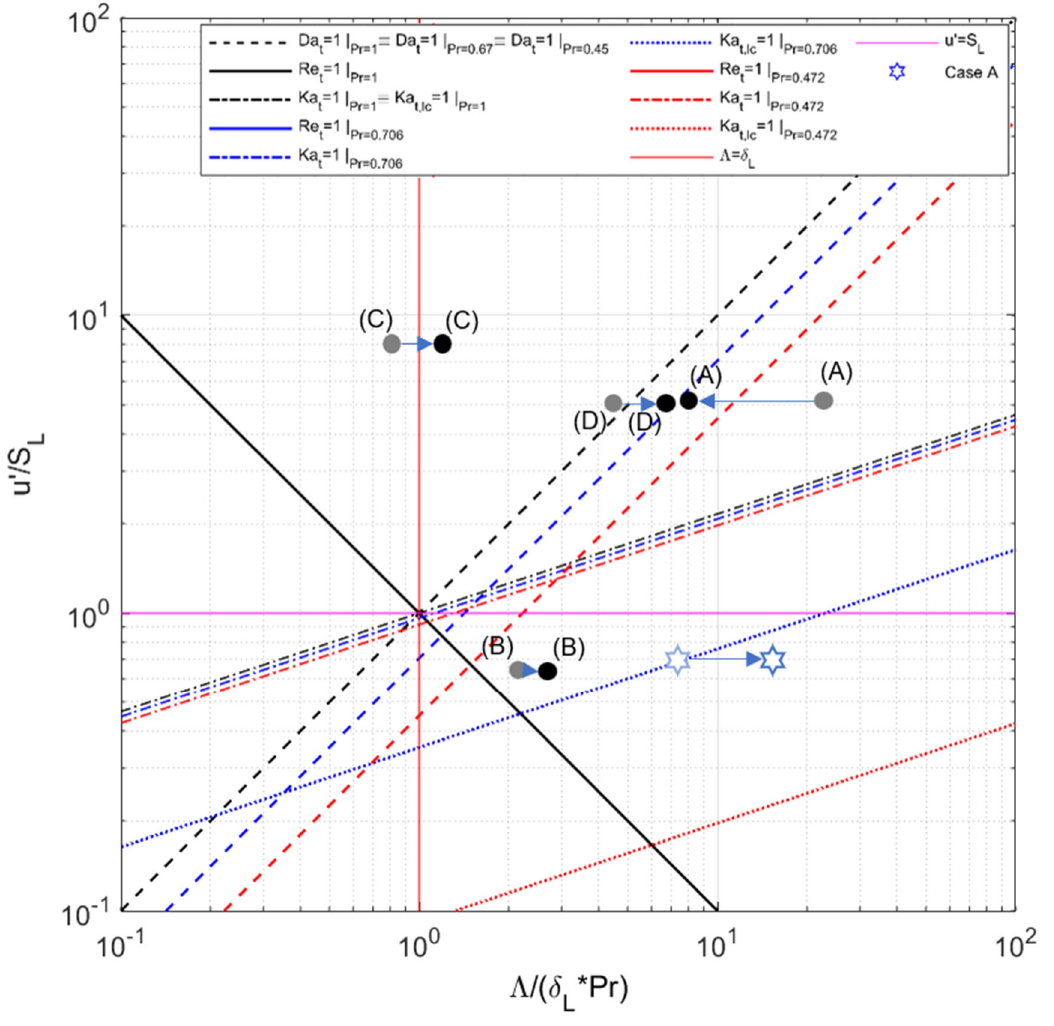
Figure 9. Modified regime diagram for premixed Flames with non-changing isoline for Re t . Simu- lations of different operating points are plotted. The arrows indicate how the relative positions of several example cases change due to the modification of the x